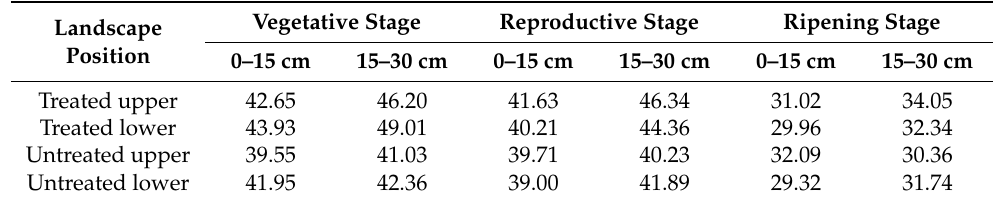
Table 5. Effects of SWC practice and topographic positions on soil